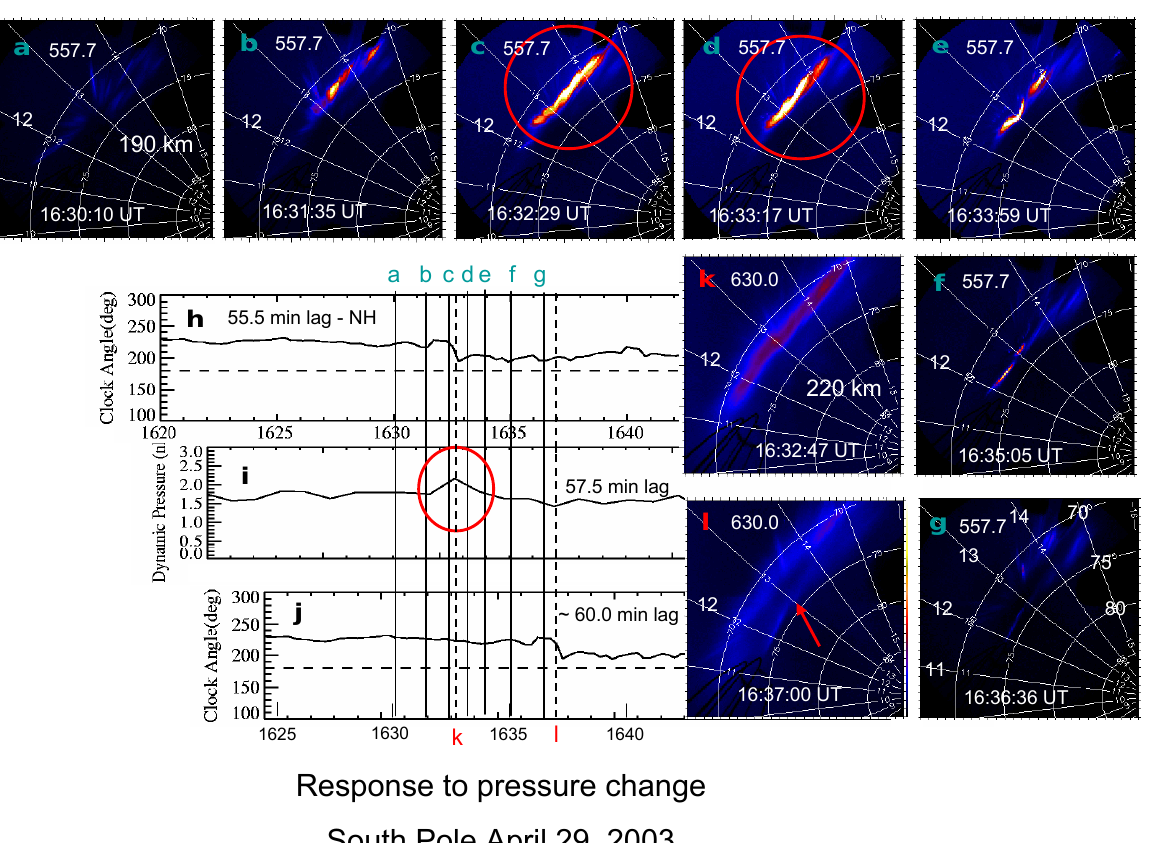
Fig. 8. (a–g) Selected 557.7nm all-sky images near 16:32 UT when an impulsive pressure increase impacted the post noon dayside mag- netopause. (h) The clock angle of the IMF measured by ACE with the lag determined for the northern hemisphere. (i) The ACE dynamic pressure lagged by 57.7min. (j) The IMF clock angle lagged by 60.5min, which is the appropriate lag for high latitude merging in the south- ern hemisphere. The red circles highlight the response to the pressure impulse. (k–l) 630.0nm all-sky images at the peak of the disturbance and ≈ 4min later to show the poleward progression of the